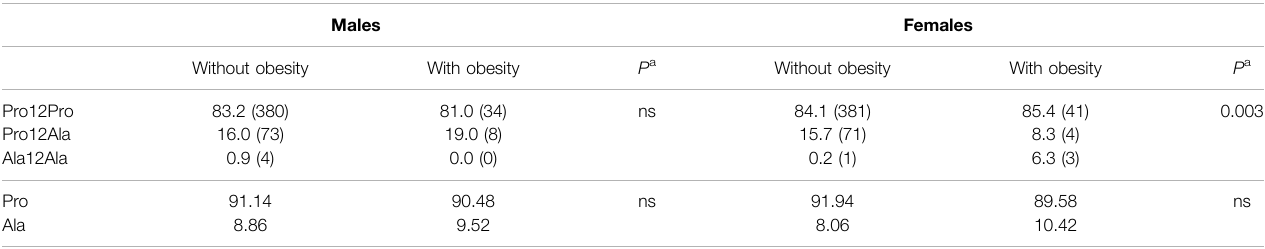
TABLE 2 | PPAR γ 2 Pro12Ala genotype and allele frequencies (% (N)) according to weight category by sex. Males Females Without obesity With obesity P a Without obesity With